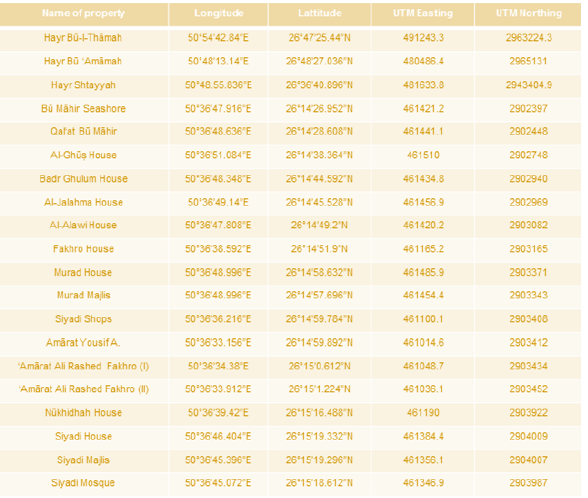
Figure 4 List of the 17 architectural structures listed in the World Heritage List in 2012. Image source (Kingdom of Bahrain Ministry of Culture & Information, 2012) adapted by the author.